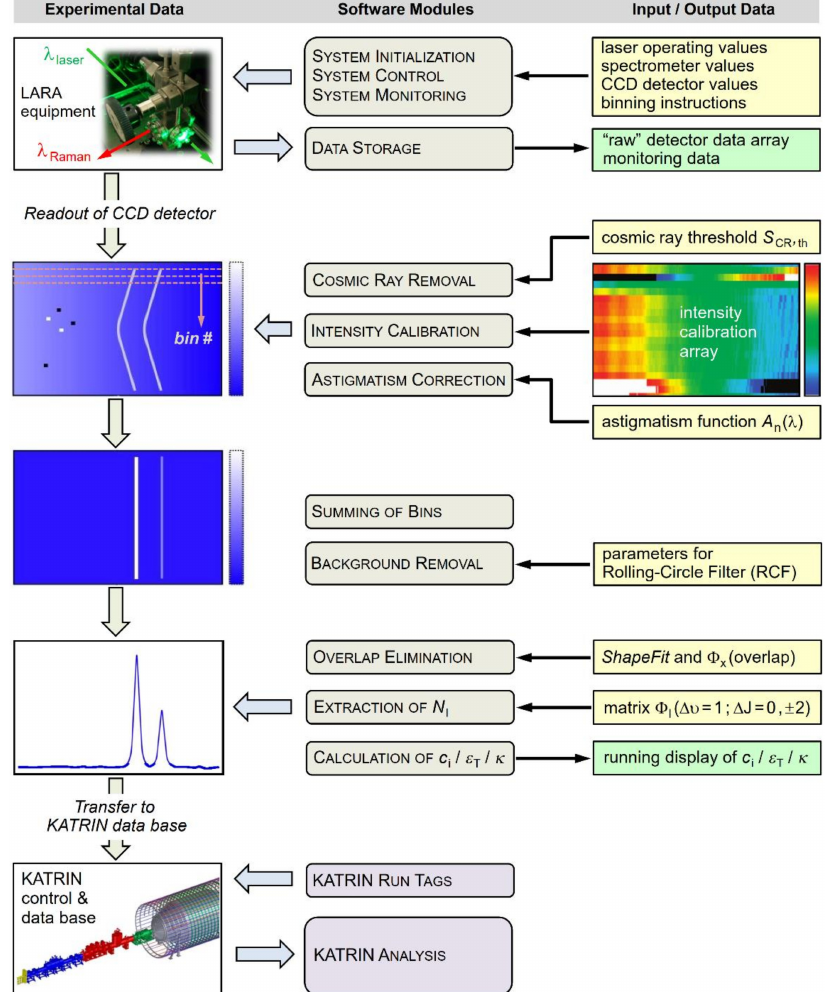
Figure 3. Concept of LARA system control and Raman data processing, based on the bespoke, modular LabVIEW suite LARAsoft . Note that the KATRIN control and data storage routines are not part of LARAsoft. For further details, see